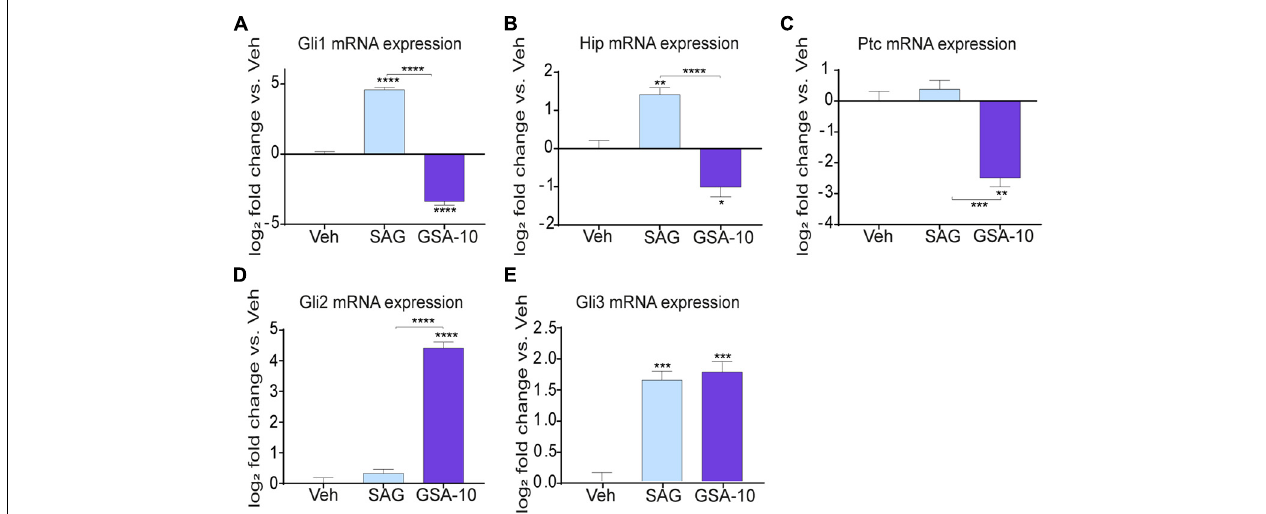
FIGURE 3 | Gli, Hip, and Ptc expression analysis and Smo localization in Oli-neuM. (A–E) Gli1, Gli2 Gli3, Hip, and Ptc expression levels in Oli-neuM treated for 48 h with 10 µ M GSA-10, 5 µ M SAG, or vehicle. Data were normalized and plotted as log2 fold change. Values are mean ± SEM ( n ≥ 3) with respect to vehicle. Two-tailed paired Student’s t -test was performed for statistical significance versus vehicle. One-way ANOVA with Tukey’s multiple comparison test was performed to analyze GSA-10 vs. SAG statistical significance among different treatments. * p < 0.05, ** p < 0.01, *** p < 0.001, and **** p <